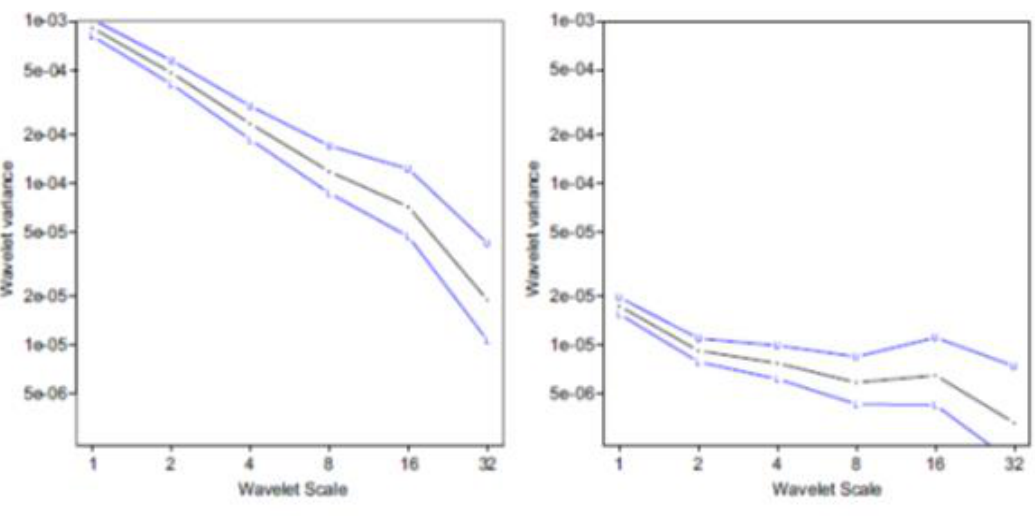
Fig. 1. Wavelet variance for the BSE index and NSE index at log-log scale